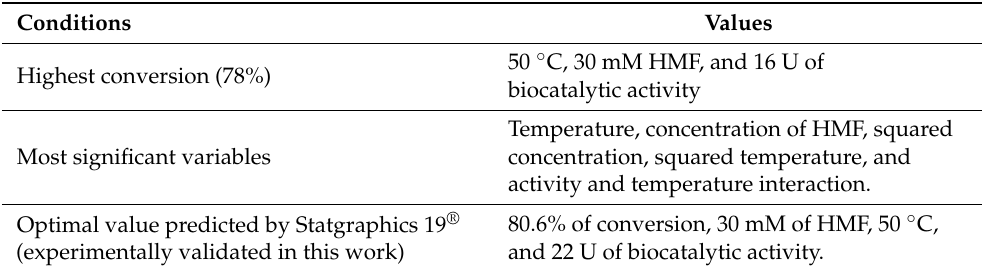
Table 3. Summary of the variables and conditions that maximize the conversion of the reaction to produce 5-lauryl hydroxymethylfurfural catalyzed by immobilized TL lipase using 1000 mM lauric acid.